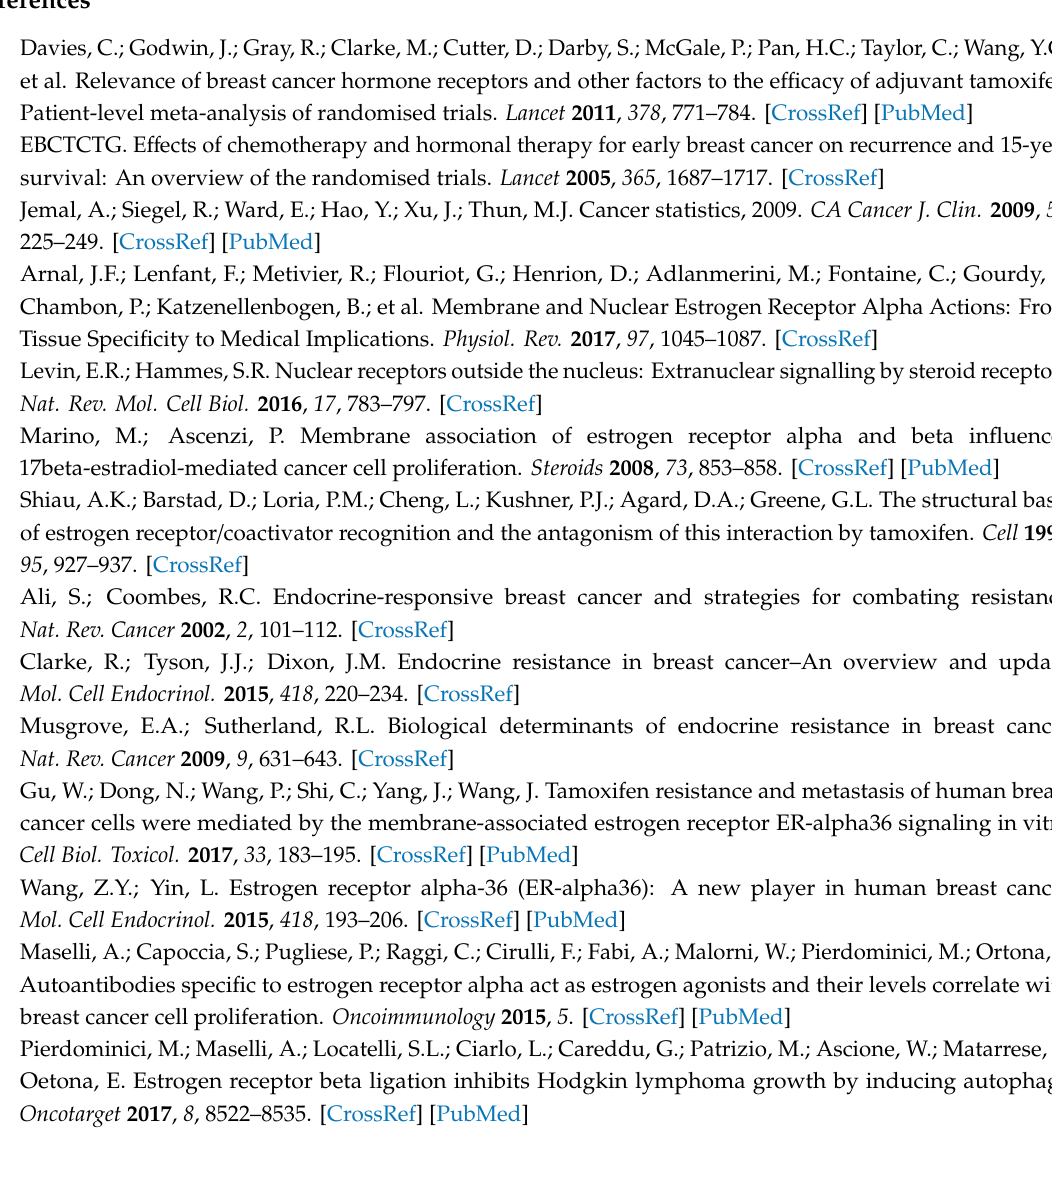
Figure S1: SDS-PAGE under reducing condition analysis (Coomassie brilliant blue staining) of human anti-ER α Abs obtained from early ER-positive breast cancer patients., Figure S2: Cell proliferation evaluated by flow cytometry measuring Ki-67 nuclear antigen expression in MCF-7 cells treated or not for 24 h with E2 (10 nM), E2 + anti-ER α Abs (50 µ g / mL), E2 + TAM 1 µ M, E2 + anti-ER α Abs +